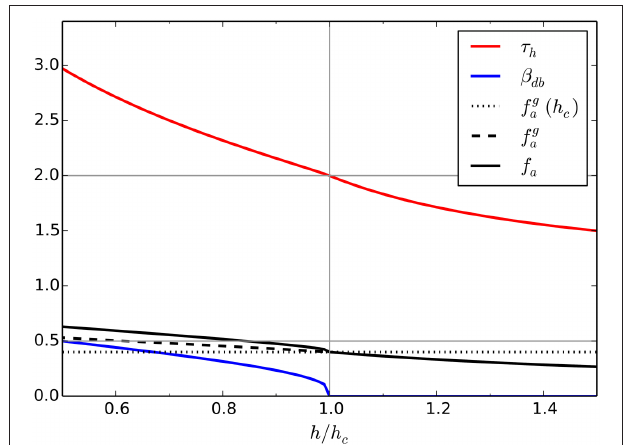
FIGURE 2 | Dependence of the parameters τ h , β db and the different approximations of the advective ratio f a (see main text) on the height of the upper control surface (depth of the control volume), for the topography to be introduced in Section 3 and illustrated in Figure